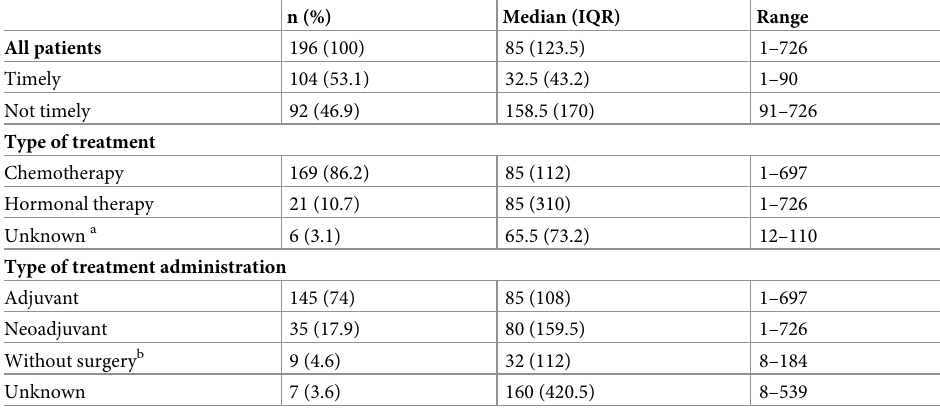
Table 2. Systemic treatment initiation interval by treatment and type of administration.